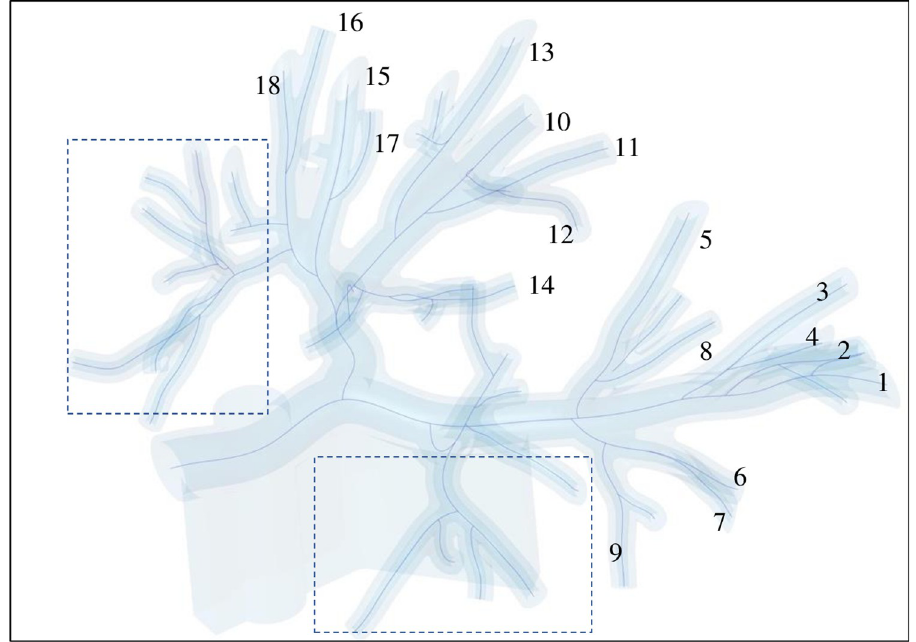
Fig 4. Lung airways successfully navigated using the FBG catheter and the AIrShape software application (numbered 1–18). Dashed line rectangles: upper lobe airways not navigated with this approach due to limitation of the bending radius of the FBG